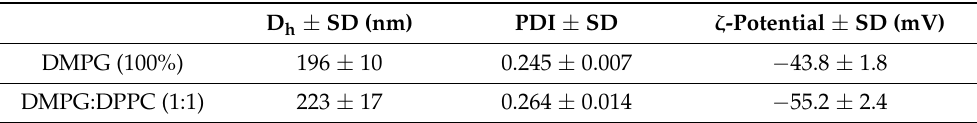
Table 3. Hydrodynamic diameter (D h ), polydispersity index (PDI), and zeta ( ζ ) potential of DMPG (100%) and DMPG:DPPC (1:1) liposomes (SD from three independent measurements).